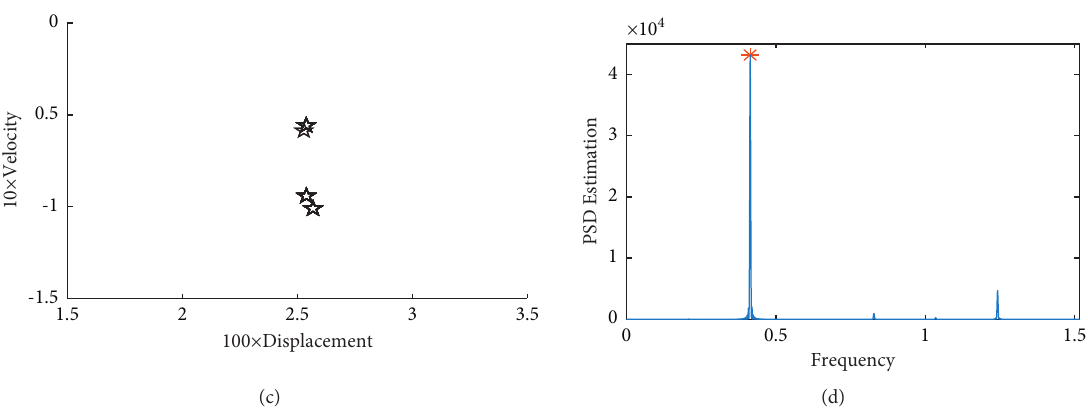
Figure 7: f � 0 . 414 Hz ， asymmetric period 4-4-4. (a) Time history graph. (b) Phase diagram. (c) Poincar´e section. (d) Power spectral density diagram.